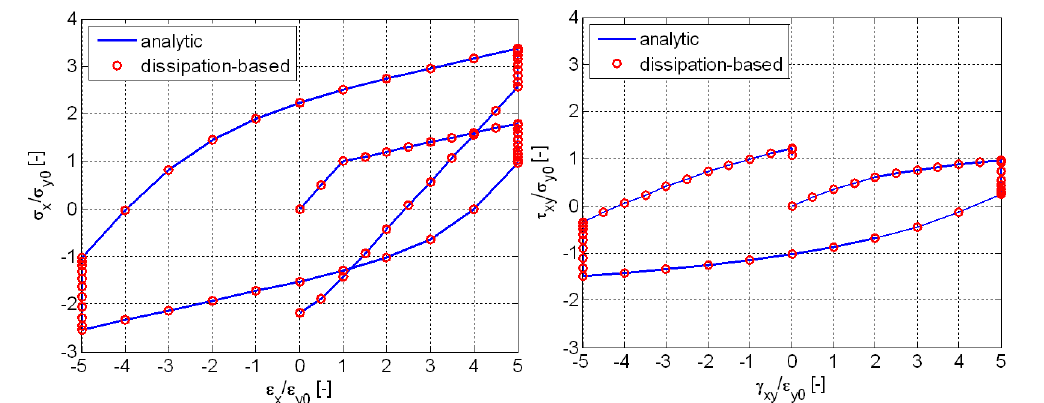
Figure 2: Pointwise mixed stress-strain test. Comparison between analytic and numerical solution for von Mises yield surface.